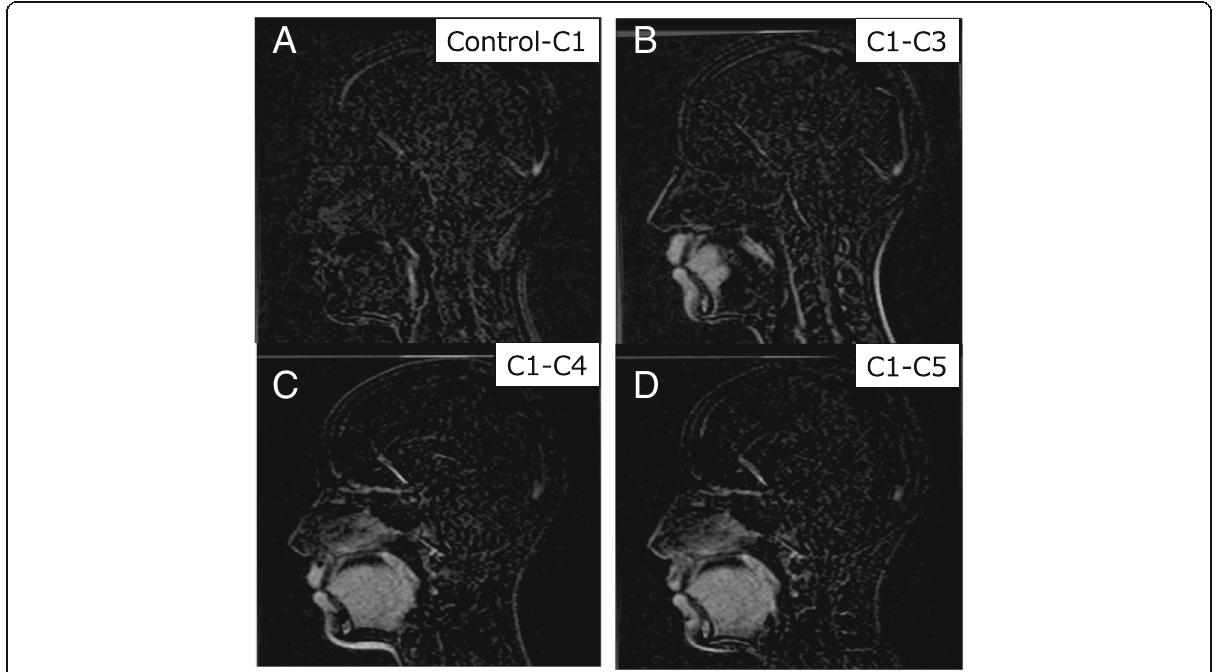
Fig. 9 Subtracted images. a Subtraction of control from C1; b subtraction of C1 from C3; c subtraction of C1 from C4; d subtraction of C1 from